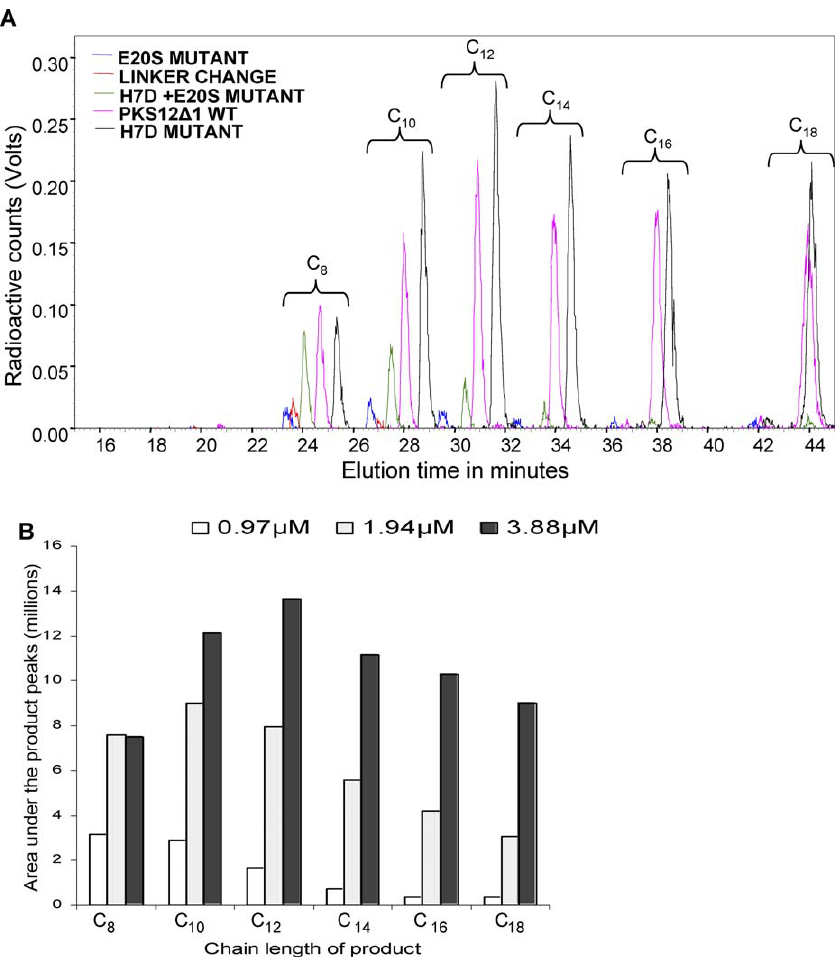
Figure 7. Quantitative Radio-HPLC Analyses of Linker-Change and Single Amino Acid Linker Mutants of PKS12 D 1 and Effect of Concentration on PKS12 D 1 Catalysis (A) The radioactive products synthesized by PKS12 D 1 and PKS12 D 1 mutant proteins were analyzed on reverse-phase HPLC, and the elution times were determined by using a radioactive detector. All reactions were primed by hexanoyl starter that undergoes two carbon extension(s) with MCoA. Trace for E20S mutant (blue) shows exact retention time while traces of all other mutant proteins are stacked with an x -axis offset for clarity; linker-change protein (red), H7D þ E20S mutant (green), wild-type PKS12 D 1 (pink), and H7D mutant (black). Chain lengths of standard fatty acids eluting at these retention times are marked on these stacked traces. Value of 0.01 V is considered as background, based on the control experiments. (B) Comparison of concentration dependent changes in the product profiles catalyzed by PKS12 D 1. Gradation in color indicates increase of protein concentration for each set of peaks, which in turn depict the product formed. At higher protein concentration, more of longer chain length products are synthesized, since there is a shift in equilibrium towards higher order multimeric